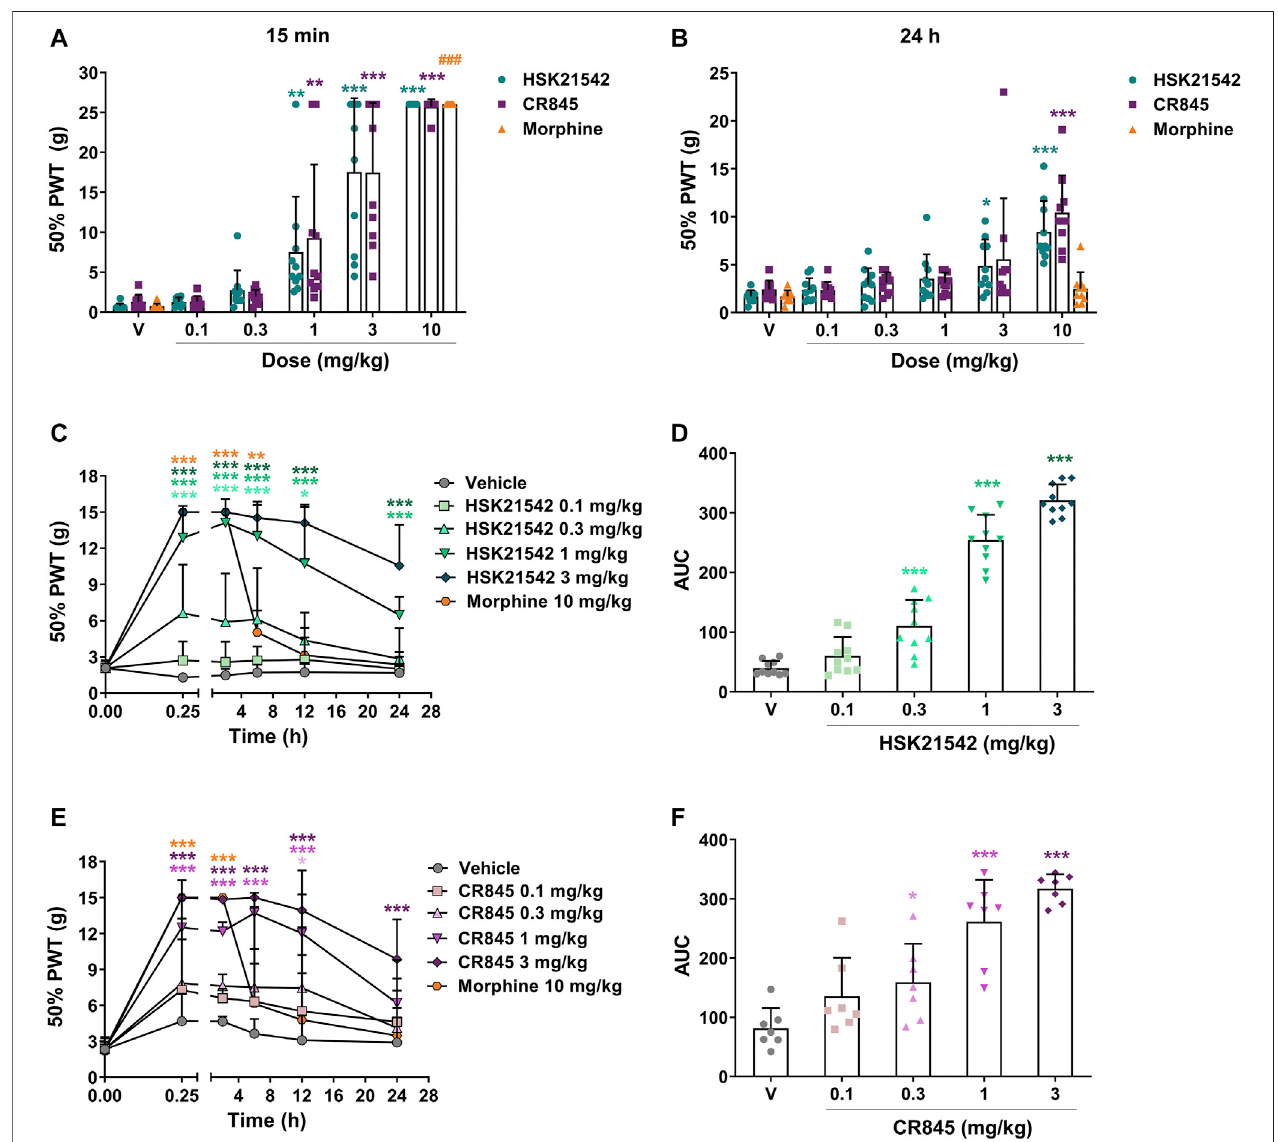
FIGURE 4 | Antiallodynic effects of HSK21542 and CR845 in hindpaw incision- or CCI-induced mechanical pain. In hindpaw incision model, the mechanical allodynia testing (von Frey) was performed at 15 min (A) and 24 h (B) after drug administration. In CCI model, mechanical allodynia testing was performed at 0.25, 2, 6, 12and24 hpost-drug (C,E) ,andtheareaunderthecurve(AUC)wascalculatedusingatrapezoidal method (D,F) .Morphinewaspresented asapositivecontrol.Data arepresentedasmeans ± SD( n (cid:1) 7 – 10/group).(AandB)* p < 0.05,** p < 0.01,*** p < 0.001vs.vehicle,Kruskal-WallistestfollowedbyDunn ’ spost-hoctest; (C,E) * p < 0.05, ** p < 0.01, *** p < 0.001 vs. vehicle, two-way ANOVA followed by Dunnett ’ s test; (D, F) * p < 0.05, *** p < 0.001 vs. vehicle, one-way ANOVA followed by Dunnett ’ s test; ### p < 0.05 vs. vehicle, Mann-Whitney test. V,